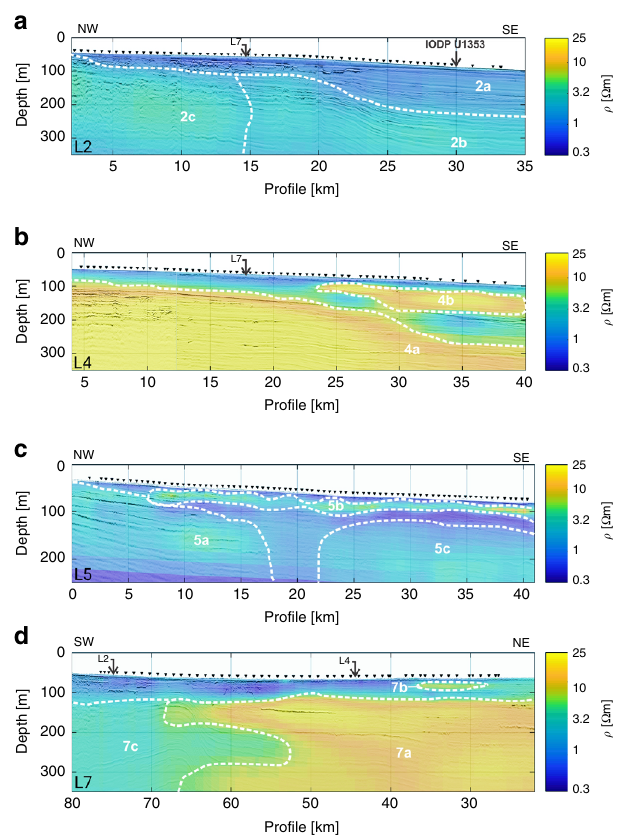
Fig. 4 CSEM lines. Interpreted resistive features from the data acquired along lines 2, 4, 5, and 7, overlaid on seismic re fl ection pro fi les (see Table 1). The features are denoted by white labels whereas their boundaries are delineated by broken white lines. Location in Fig. 1. Location of intersecting lines and borehole U1353 is shown. Black triangles mark sea fl oor CSEM transmitter positions on